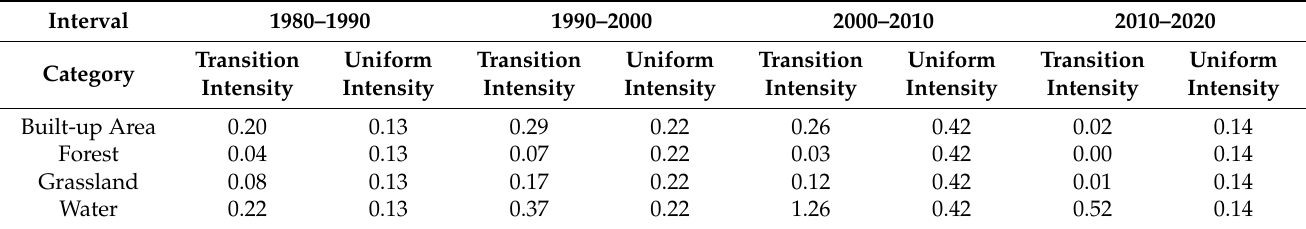
Table 22. Transition to